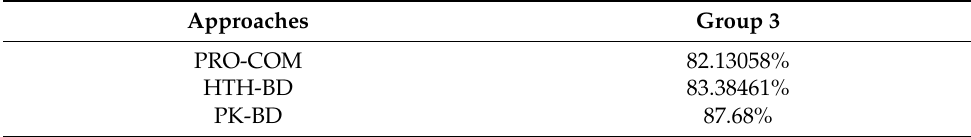
Table 23. The accuracy of user survey using ML (group